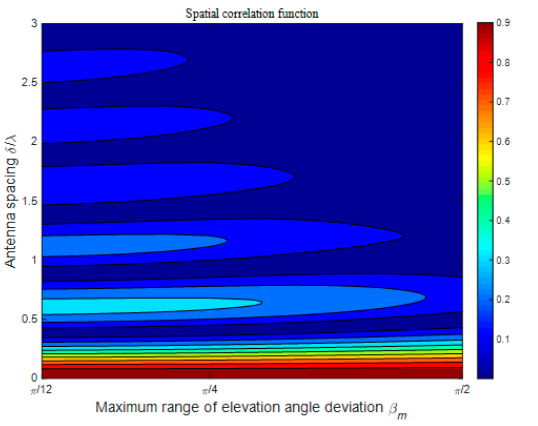
Figure 5. Analytical results of the spatial CF ρ pq , p’q’ ( δ T , δ R ) of the proposed model in an isotropic scattering environment for different antenna spacings δ / λ and different maximum ranges of elevation angle deviation β M .